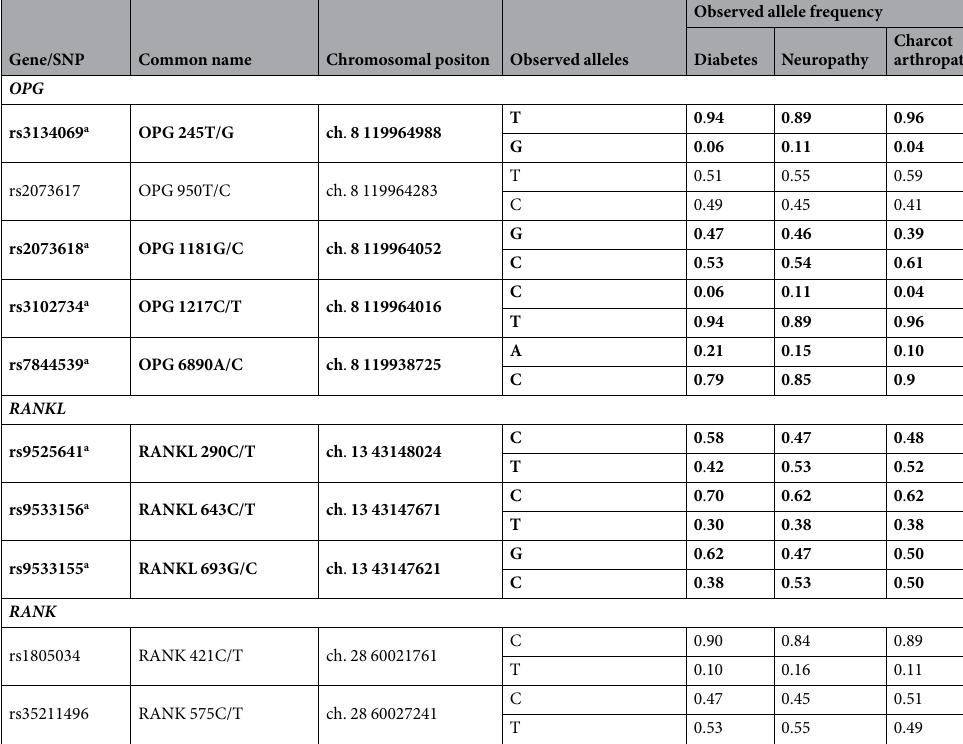
Table 1. Summary of SNPs used in the study. a Source NCBI dbSNP Population diversity (http://www.ncbi.nlm. nih.gov/SNP/). Loci showing a statistically significant allele frequency are in bold and with grey background. “Allele frequency” denotes values obtained in this study from samples of the Diabetes, Neuropathy and Charcot arthropathy patient